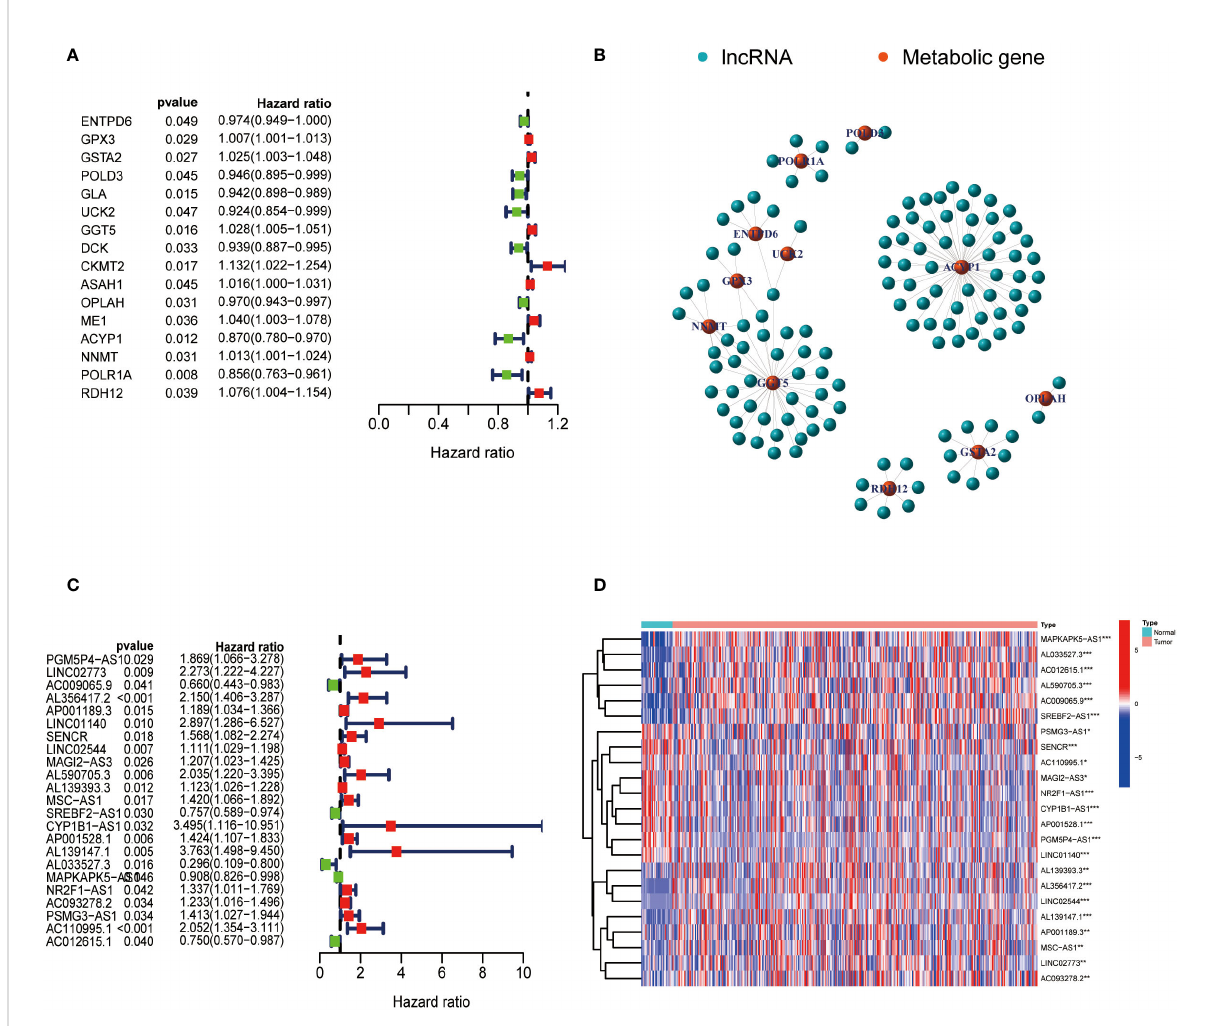
FIGURE 1 Identi fi cation of metabolic lncRNAs. (A) Metabolism-related genes signi fi cantly associated with the prognosis of GC patients. (B) Interaction network diagram for relationship between metabolism-related genes and their relationship with lncRNAs. (C) Forest plot of lncRNAs expression by one-way Cox analysis, where red represented high risk lncRNAs and green represented low risk lncRNAs. (D) Heatmap of metabolic lncRNAs expression in normal and tumor samples. Red represented upregulated expression, and blue represented downregulated expression. *p<0.05, **p < 0.01 and ***p <